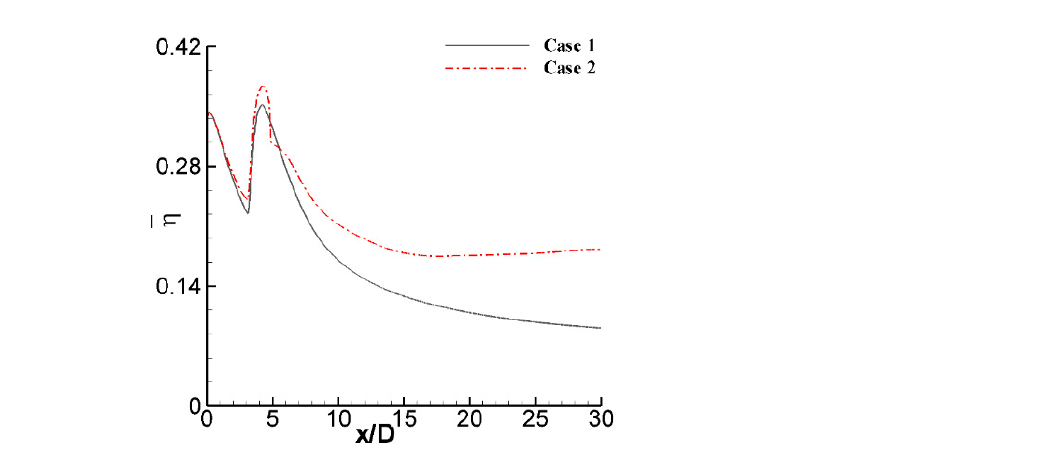
Figure 9. The comparison of the spanwise-averaged film cooling effectiveness η of Case 1 and Case 2.